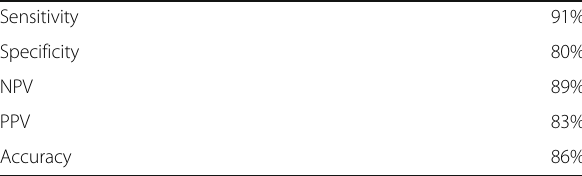
Table 2 PET/CT sensitivity, specificity, positive predictive value, negative predictive value, and accuracy for all carcinomas and adenomas with high-grade dysplasia per